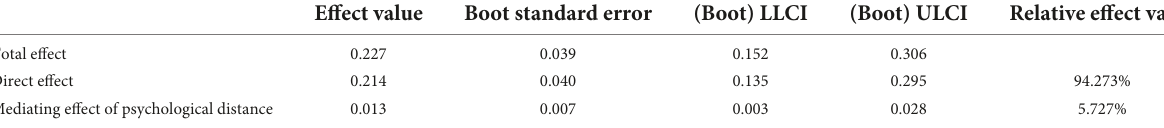
TABLE 5 Breakdown table of total effect, direct effect, and mediating effect.